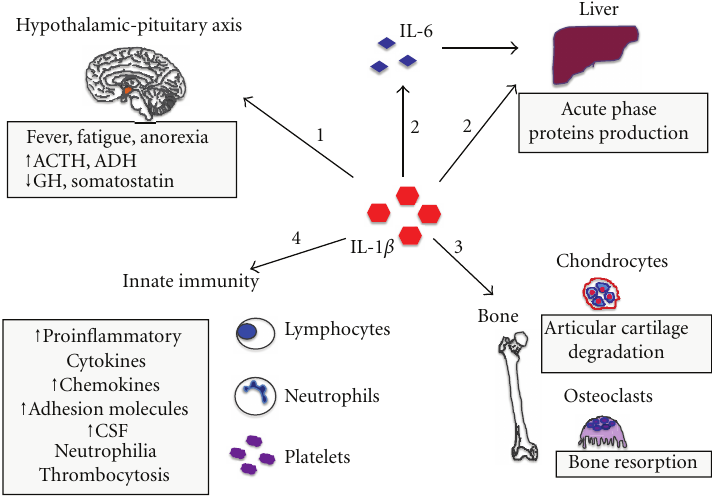
Figure 1: Main e ff ects of IL-1. (1) The action on the hypothalamic-pituitary axis influences the production of the following hormones: adrenocorticotropic hormone (ACTH), growth hormone (GH), vasopressin or antidiuretic hormone (ADH), and somatostatin. IL-1 is responsible for the constitutional symptoms in IL-1-dependent diseases (fever, fatigue, anorexia, and growth delay). (2) Liver synthesis and secretion of acute phase proteins (both by direct IL-1 action and via IL-6 induction). (3) Osteoclasts activation and matrix metalloproteinases (MMPs) synthesis by chondrocytes, resulting in bone resorption and cartilage degradation, respectively. (4) Innate immune system cells activation and proliferation, enhanced gene transcription of proinflammatory molecules (inducible nitric oxide synthase (iNOS), cyclo- oxygenase 2 (COX2), and phospholipase A2), proinflammatory cytokines, adhesion molecules, and colony-stimulating factors